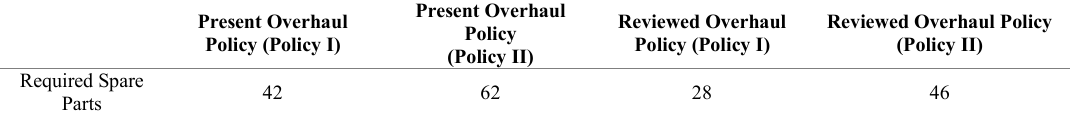
Table 3. Estimated spare parts for policies I and II.